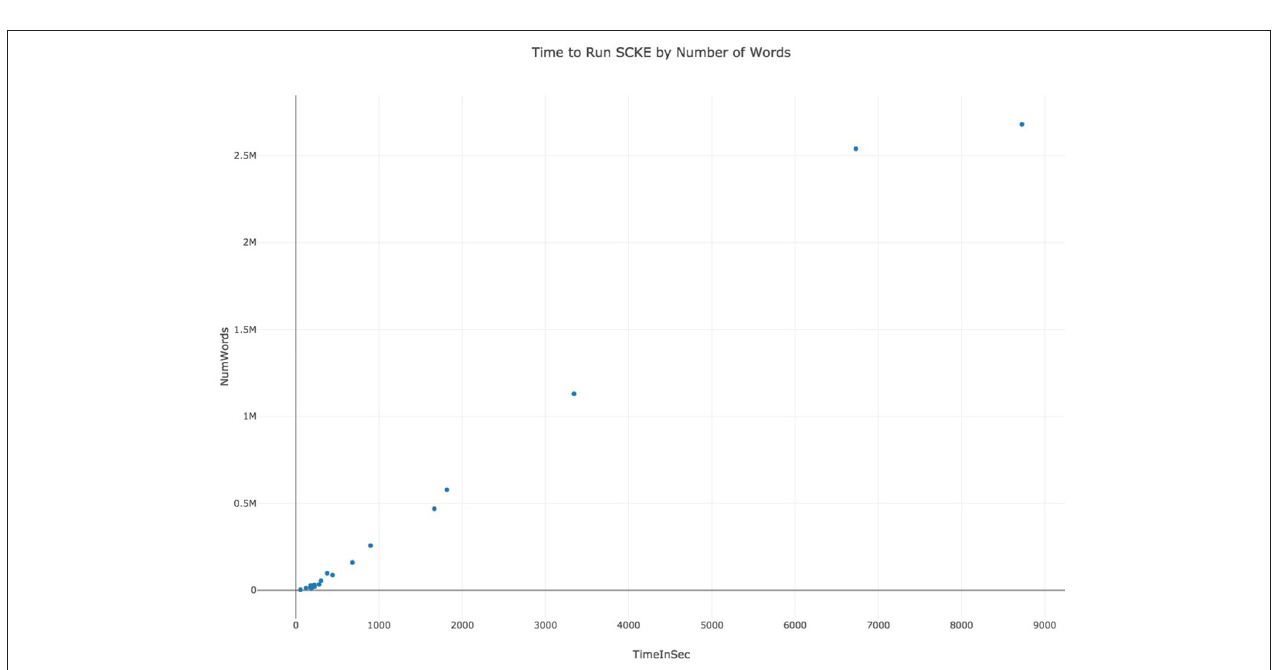
FIGURE 3 | Benchmarking data displaying the time it takes to run SCKE by the total number of words in the collection of